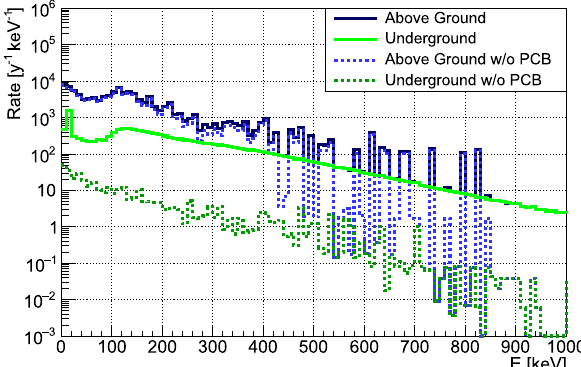
Fig. 7 The rate of interactions in the Round Robin chip is reported as a function of the energy that they deposit in the silicon chip. The majority of interactions deposit tens/hundreds of keV. Solid lines: total rate expected in a typical above ground laboratory (blue) and in the INFN-LNGS underground site (green). Dashed lines show what would betherateinthetwocaseswithoutthePCBcontribution.Aboveground, the effect of the PCB is almost negligible, as the rate is dominated by far radioactive sources. On the contrary, in the deep underground INFN- LNGS the PCB is the major contribution to the interaction rate. As a consequence, substituting the PCB with a more radio-pure one would allow to abate the rate of interactions in the chip